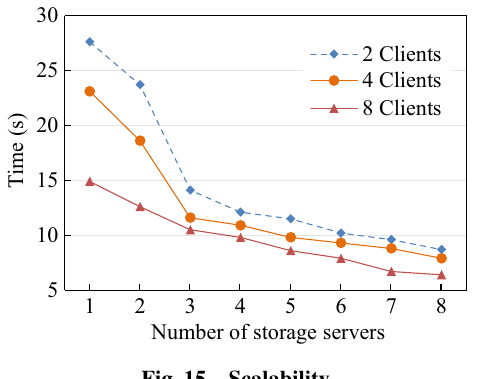
Fig. 14 Effects of data